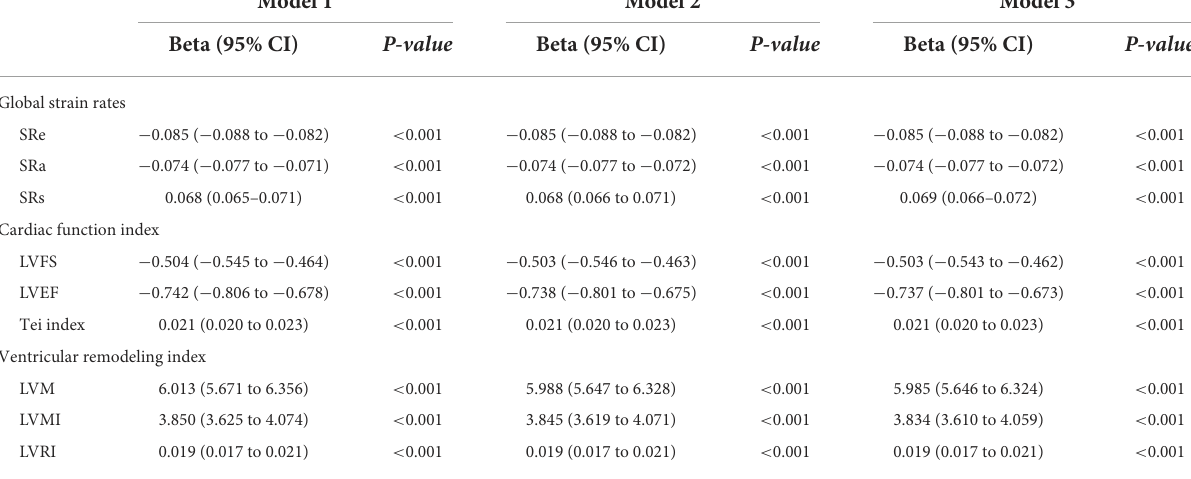
TABLE 3 Association between salt intake and strain rates and left ventricular function and